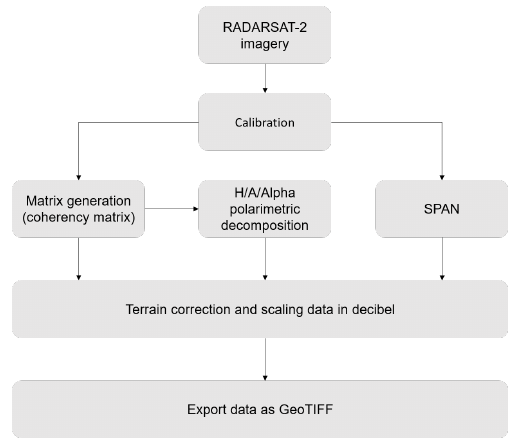
Figure 2. Workflow diagram for pre-processing chain